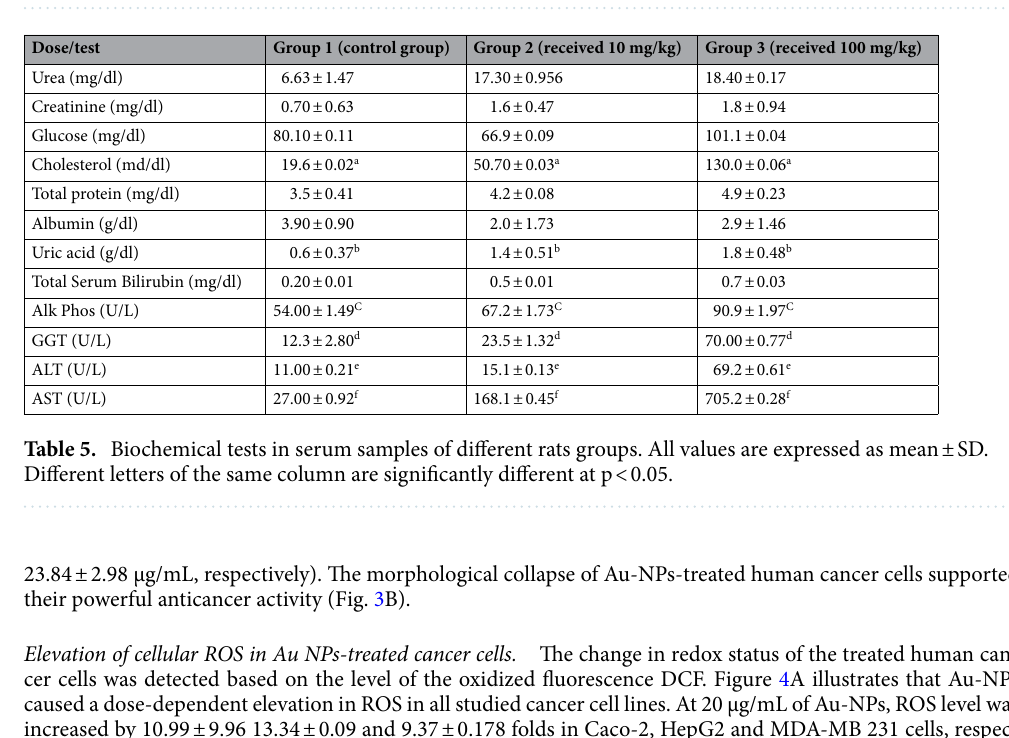
23.84 ± 2.98 µg/mL, respectively). The morphological collapse of Au-NPs-treated human cancer cells supported their powerful anticancer activity (Fig. 3B). Elevation of cellular ROS in Au NPs‑treated cancer cells. The change in redox status of the treated human can- cer cells was detected based on the level of the oxidized fluorescence DCF. Figure 4A illustrates that Au-NPs caused a dose-dependent elevation in ROS in all studied cancer cell lines. At 20 µg/mL of Au-NPs, ROS level was increased by 10.99 ± 9.96 13.34 ± 0.09 and 9.37 ± 0.178 folds in Caco-2, HepG2 and MDA-MB 231 cells, respec- tively. The intracellular ROS content of the treated HepG2 with 10 µg/mL Au NPs was elevated by 7.03 ± 0.402 folds. Stimulation of apoptotic genes with suppression of oncogene. The potential of Au-NPs for inducing apoptosis was assessed using QPCR which measured the relative change in expression of key proapoptotic and antiapop- totic genes. Figure 4B demonstrates the proapoptotic potency of Au NPs via enhancement of the expression of p53 by 4.84, 6.10 and 4.44 folds in the treated Caco-2, HepG2 and MDA-MB 231 cells, respectively. Subse- quently, BAX expression was increased by 3.95, 4.96 and 3.71 folds, respectively. Meanwhile antiapoptotic gene (Bcl2) expression was down regulated by 2.67, 5.89 and 2.05 folds, respectively (Fig. 4B).